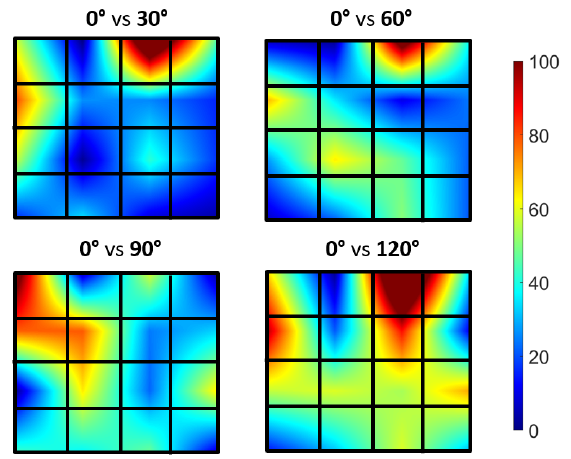
Figure 10. Muscle average movement imaging during in vivo test. The color bar represents the relative displacement of the muscle. The displacement was calculated using the forearm at 0 ◦ as the